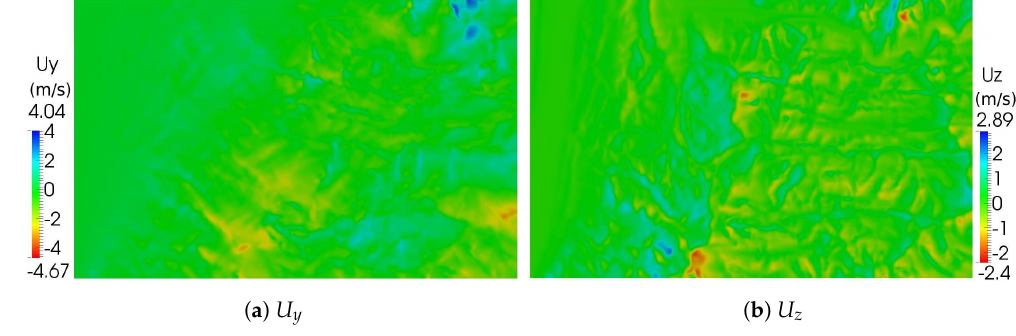
Figure 16. Velocity components in y - and z -direction at 80 m.